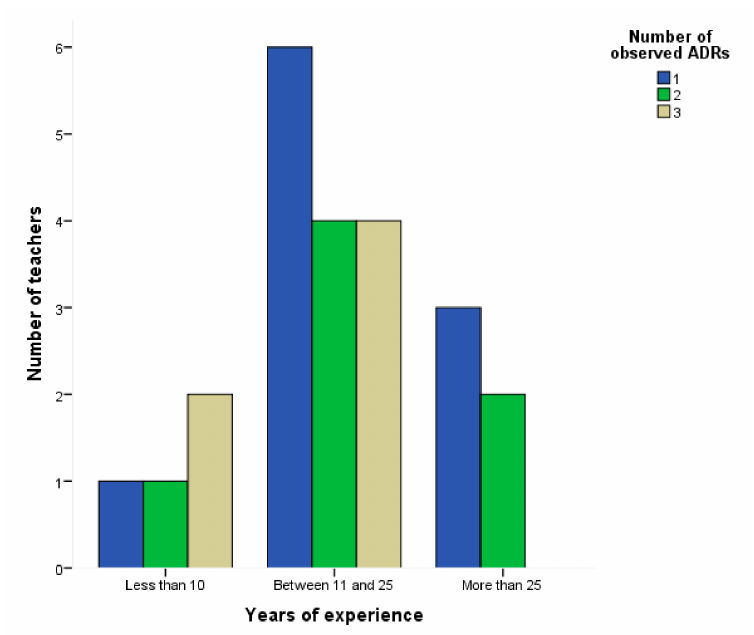
Figure 2. Number of observed adverse drug reactions by years of teaching experience.